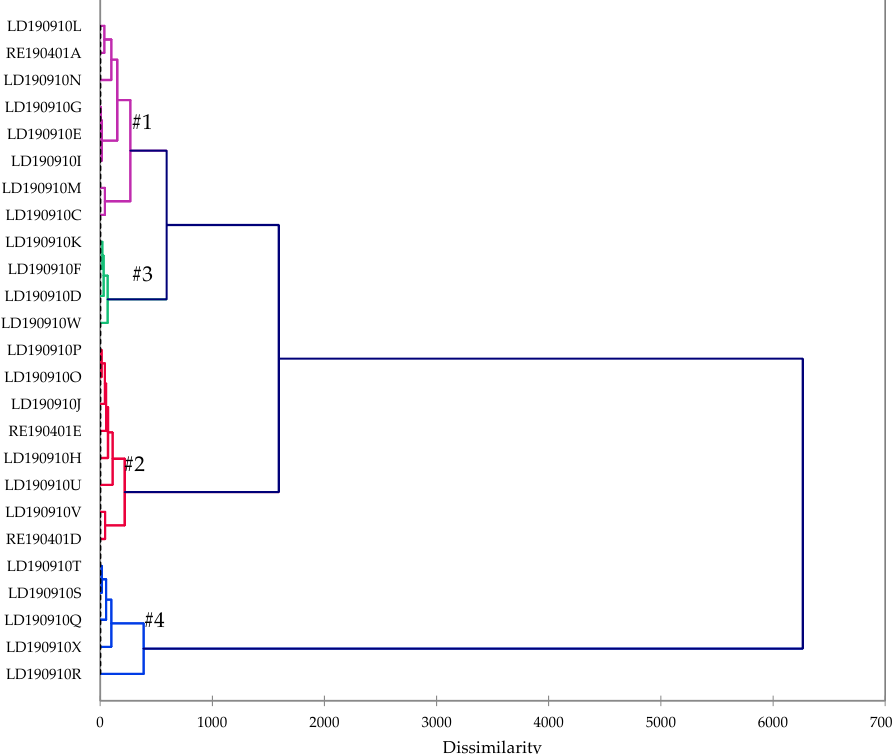
Figure1. Dendrogramobtainedfromtheagglomerativehierarchicalclusteranalysisof25 Liquidambarformosana Figure 1. Dendrogram obtained from the agglomerative hierarchical cluster analysis of 25 Liquidambar oleoresin essential oil formosana oleoresin essential oil compositions.